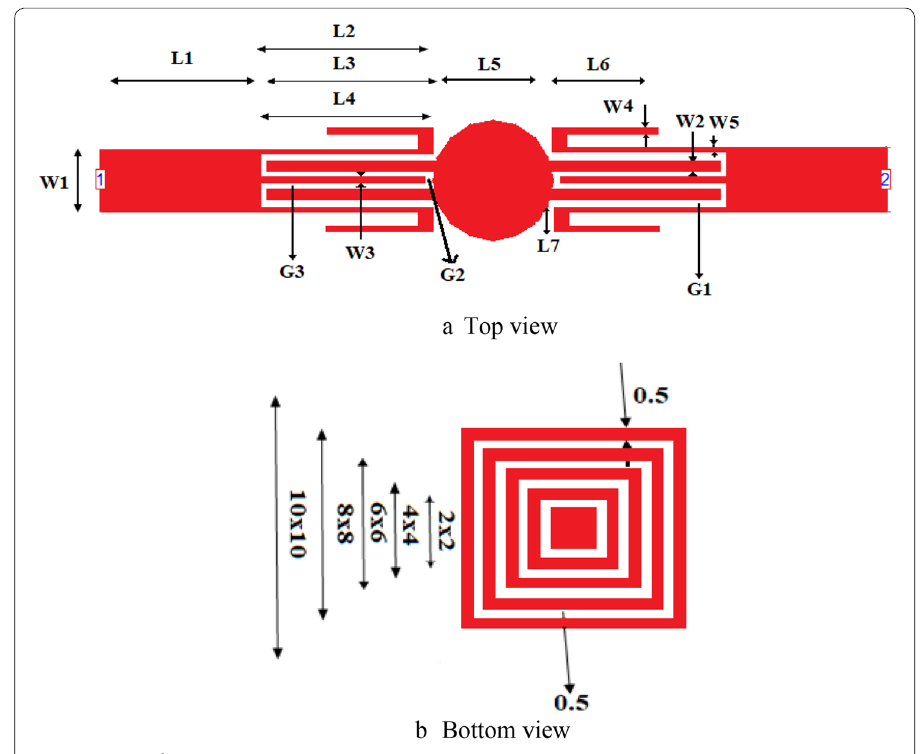
Fig. 2 Design of DB-BPF